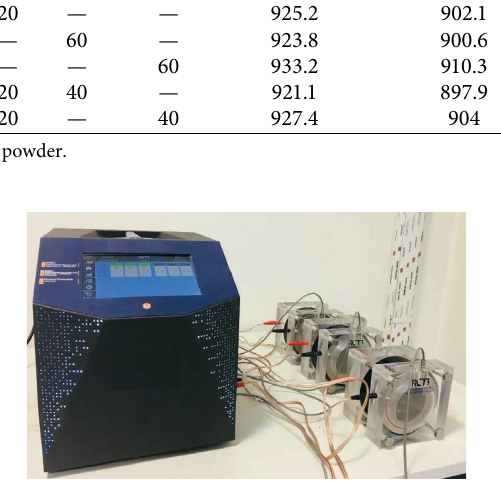
Figure 3: Rapid chloride penetrability test